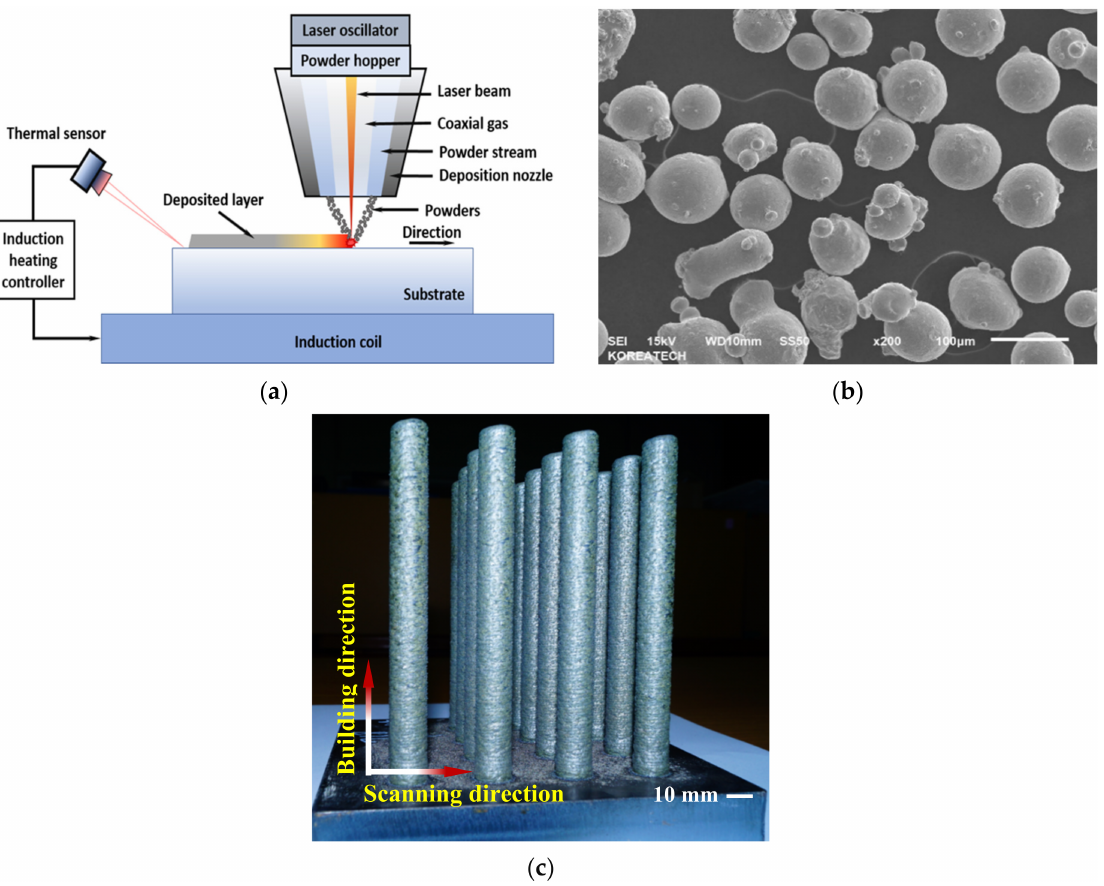
Figure 1. Schematic view of LMD process ( a ), SEM image of the particles ( b ) and LMD fabricated samples ( c ). Table 1. Chemical composition of Inconel 718 alloy fabricated by LMD